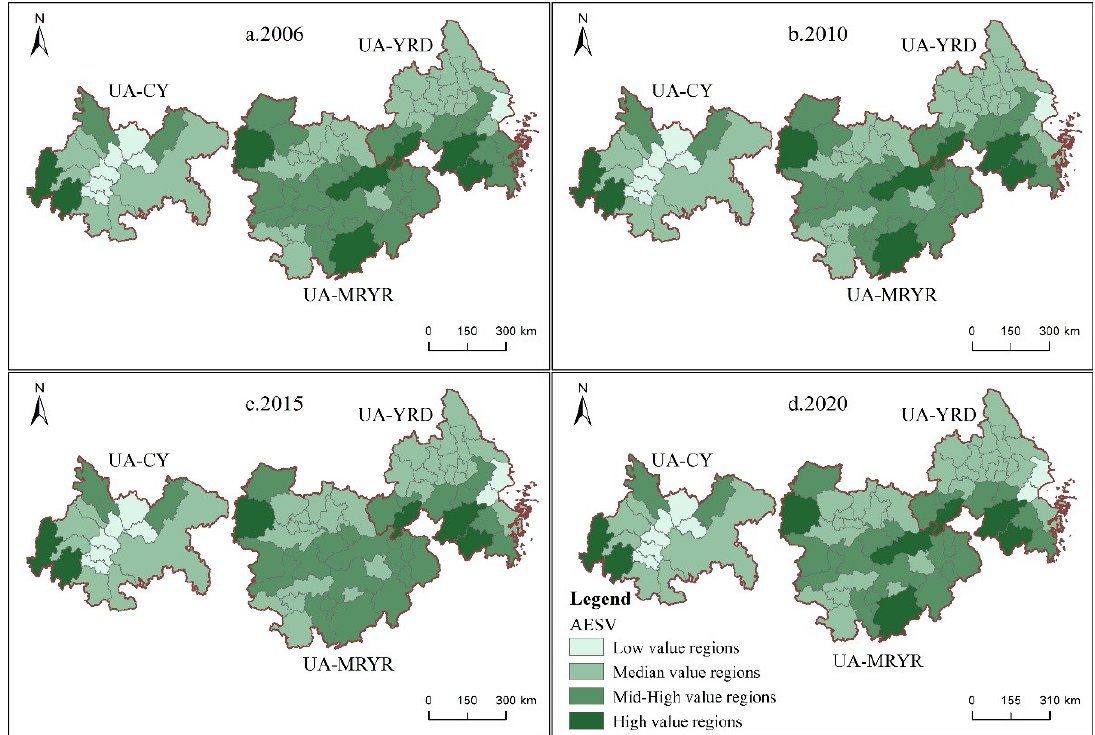
Figure 6. The spatial difference of ULEE among three major urban agglomerations.